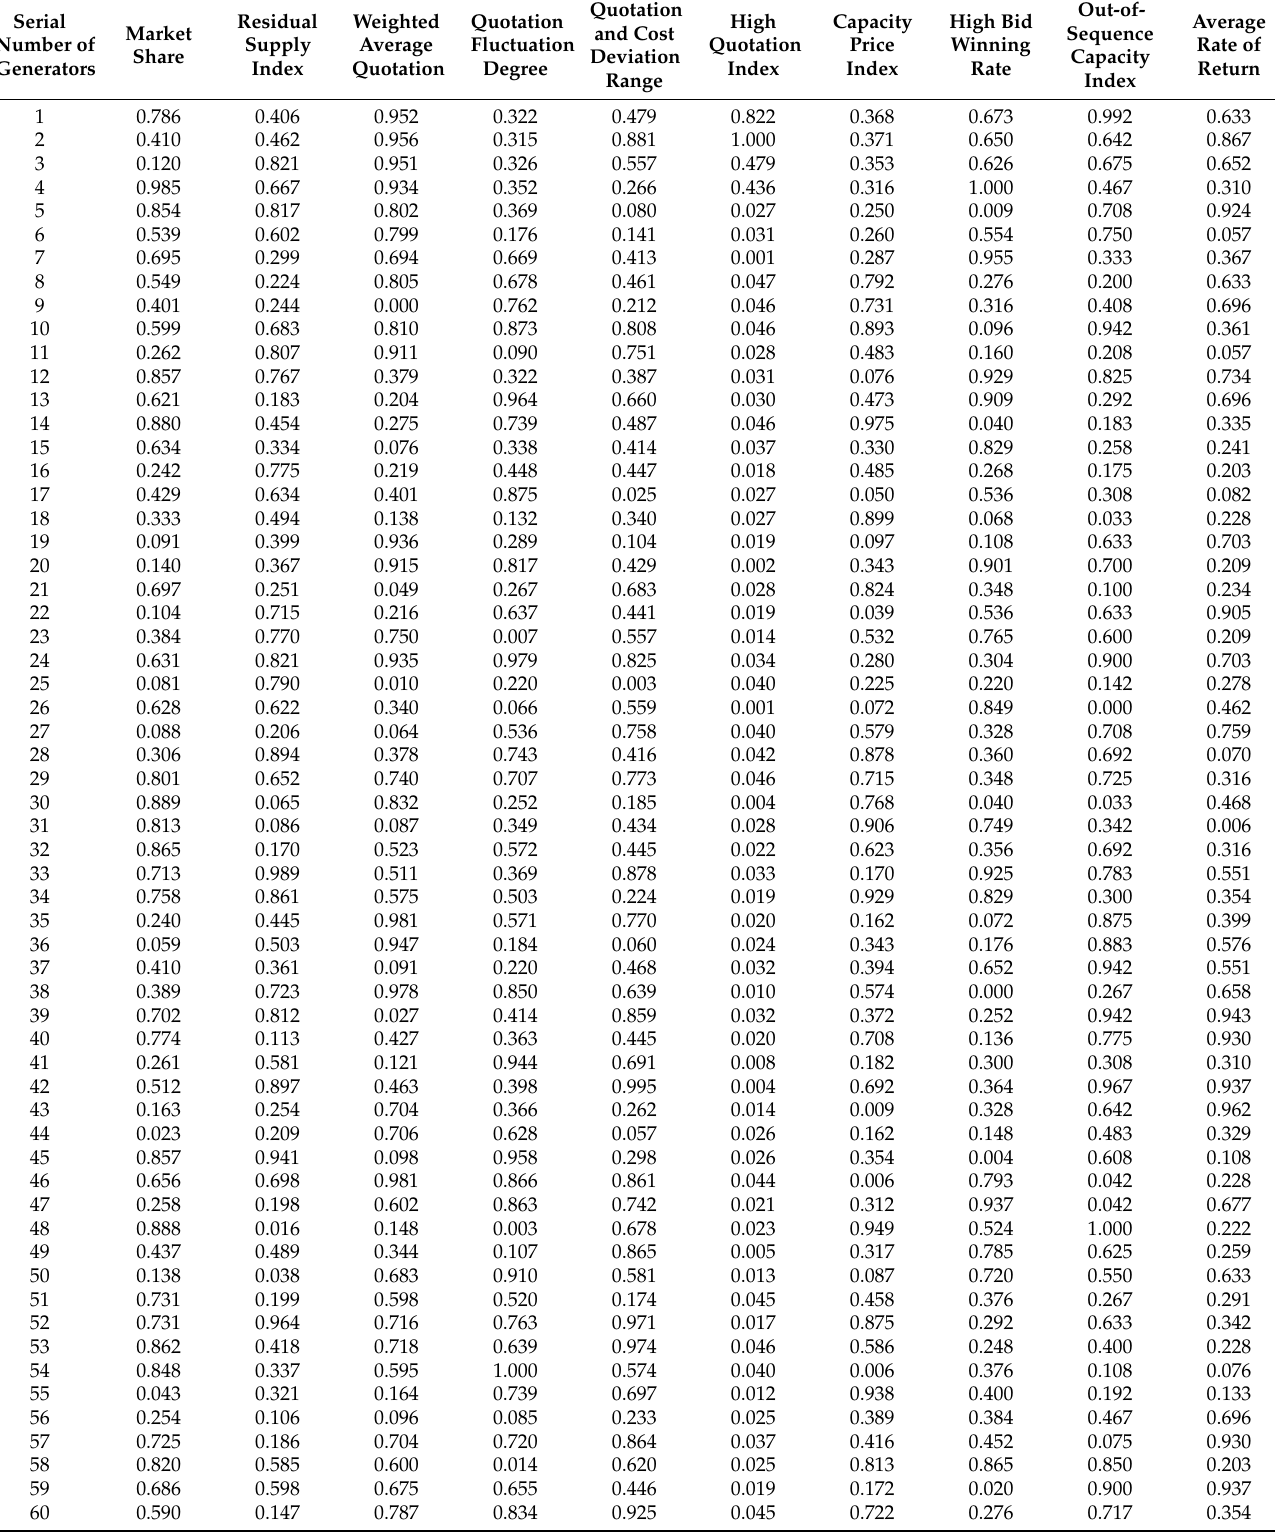
Table A1. A part of the indicator data in the case